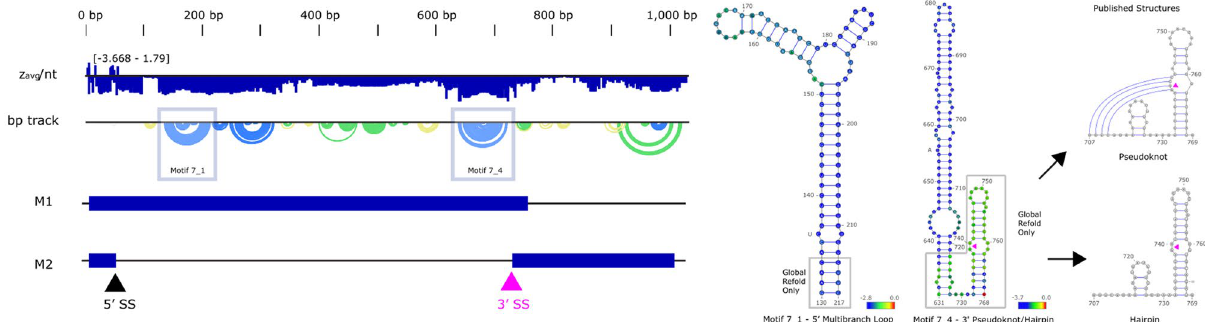
Figure 2. (Left) ScanFold data for IAV 7 ( +), with motif 7_1 and 7_4 designated by a blue box. M1 and M2 versions of this transcript are illustrated for reference. The base pair track (bp track) shows arcs correlating to base pairings, where blue arcs have a < −2 score, green arcs have a < −1 z-score, yellow arcs have a < 0 z-score, and gray arcs have a z-score > 0. (Right) Motif 7_1 correlates with the published multibranch loop 23 , aligning with our reference sequence after global refold (gray boxes). Motif 7_4 has an extended hairpin that occludes any formation of the 5 ′ pairing or pseudoknot structure around the 3 ′ splice site (739–740, purple triangles), but a global refold reveals the published 3 ′ pairing 25 . Two sequence variations from our reference sequence are annotated at 136 and 655. ScanFold z-scores are overlaid in each nucleotide circle, with blue designating < −2 z-score. Structural images were adapted from VARNA, and the genome illustrations were adapted from